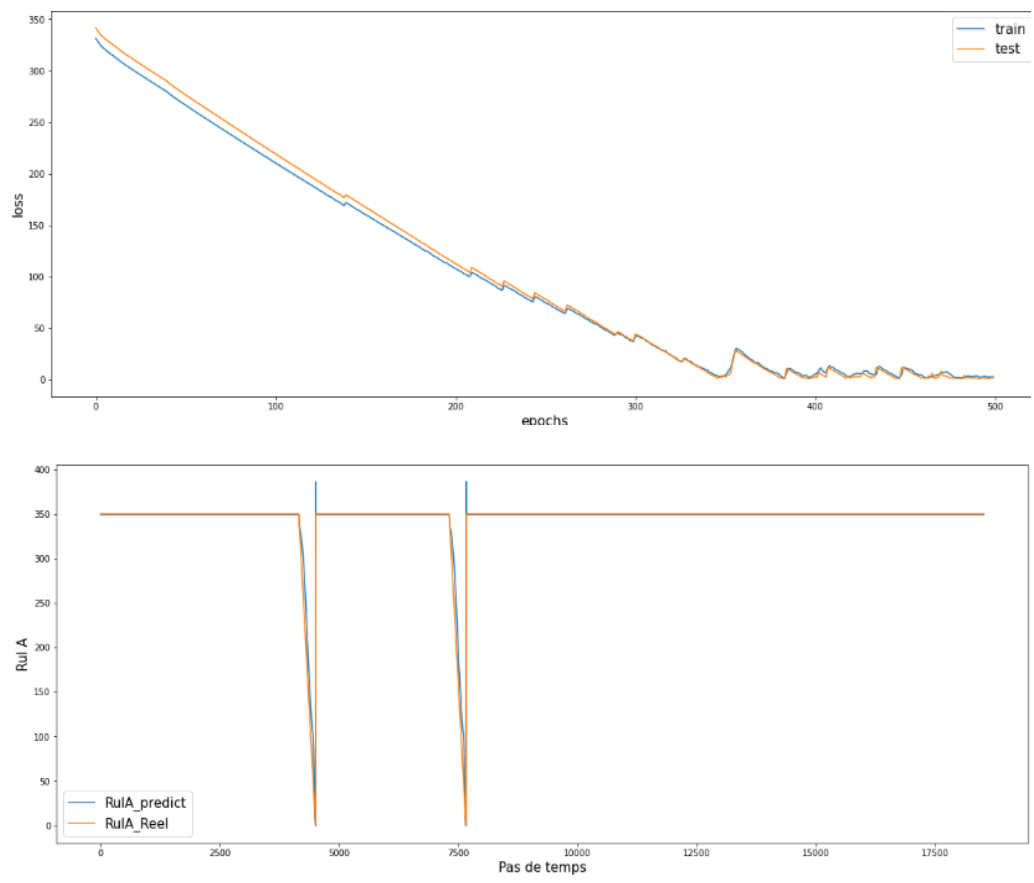
Figure 16. LSTM method for cluster 2 continuous-RULA. Mean squared error = 61.9745811938061. Cluster 3: